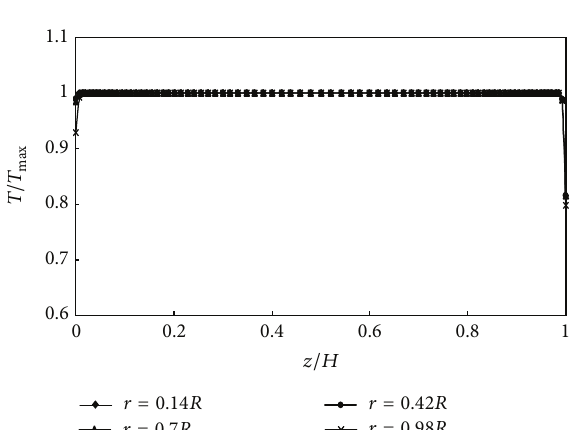
Figure 5: Profile of axial dimensionless